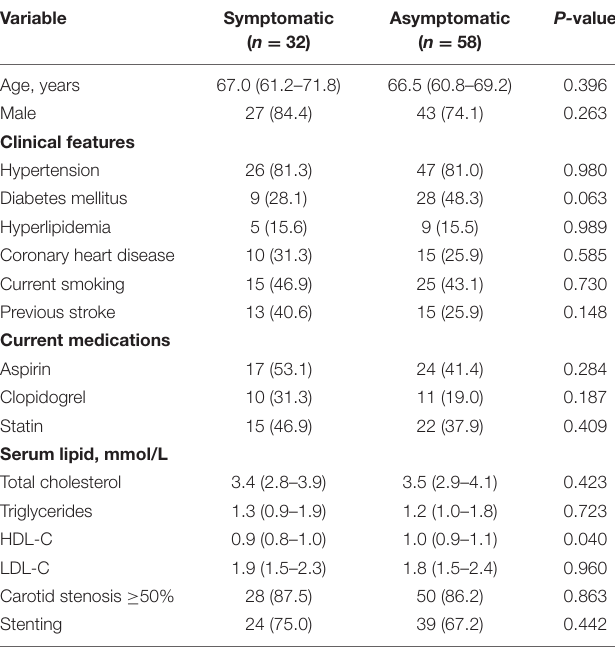
TABLE 1 | Demographic and clinical data of the study